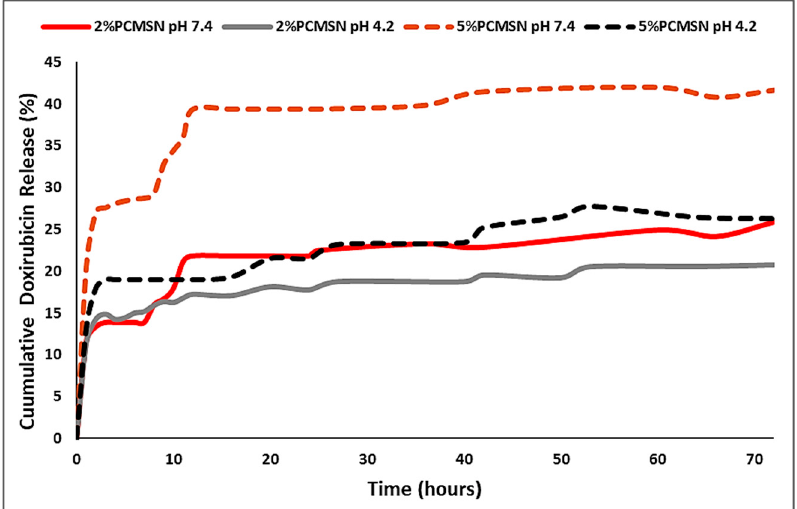
Figure 5. Drug release profiles of DOX at pH 7.4 (red / dark red series) and pH 4.2 (grey / black series) for 2% PCMSNs (solid line) and 5% PCMSNs (dashed line).